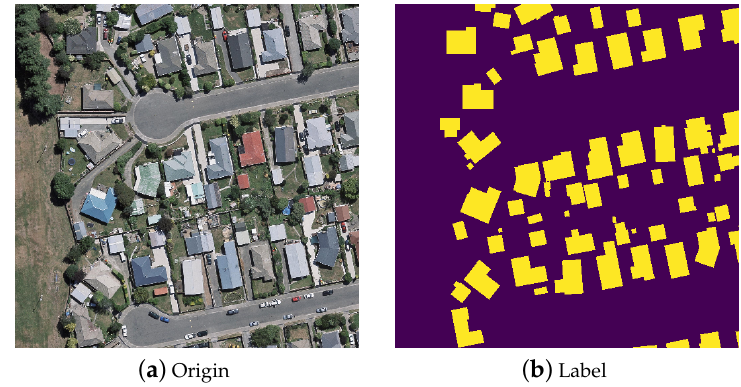
Figure 10. Sample of the WHU